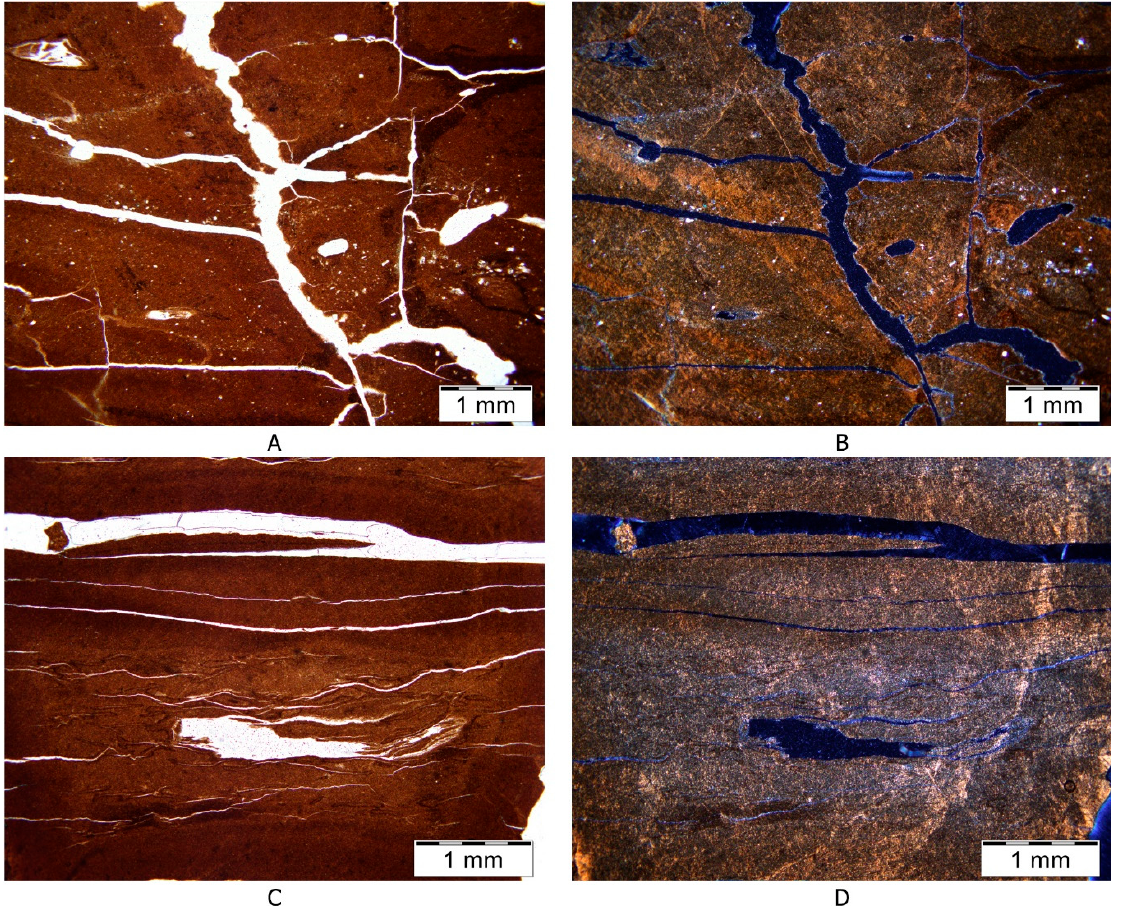
Figure 14. Microstructure of mono-clay layers of Chocolate clays untouched by pedogenesis. Left–PPL; right–XPL. ( A , B )—Leninsk exposure, 25 km East of Srednaya Akhtuba section, right side bank of Akhtuba River, 231–236 cm; ( C , D )—Raigorod exposure, 20.